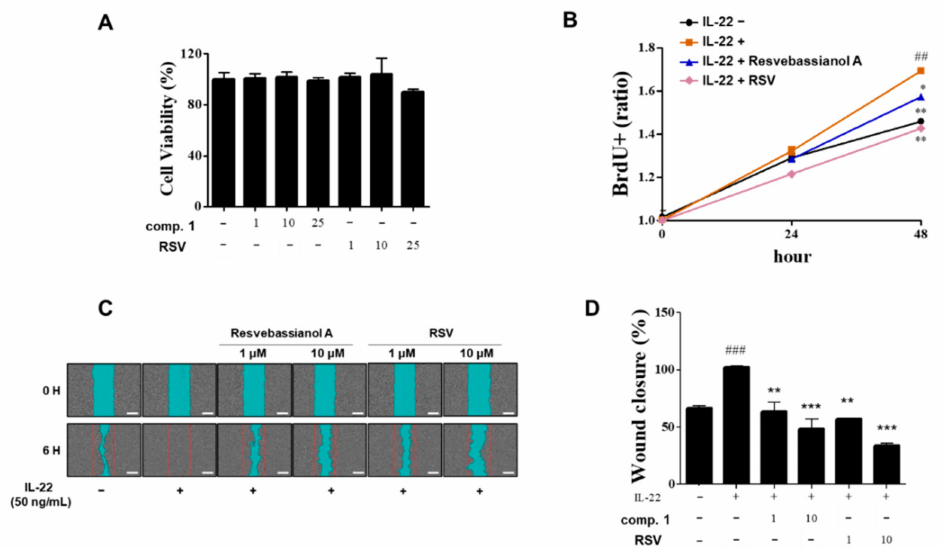
Figure 4. Effects of resvebassianol A on the proliferation and migration of HaCaT cells. ( A ) Cells were cultured in 96-well plates, and they were treated with resvebassianol A and RSV (1, 10, and 25 µ M). After 24 h cell viability was measured using the MTT assay. ( B ) HaCaT cell proliferation after 24 and 48 h of treatment with resvebassianol A and RSV was measured using BrdU incorporation assay. ( C ) The wound margin was photographed after 0 h and 6 h of wound scratching. ( D ) Quantitative analysis of wound closure was determined as the wound area at a given time relative to that of the IL-22-treated group. Values are expressed as means ± SEM. ## p < 0.01 and ### p < 0.001 versus untreated (control) group; * p < 0.05, ** p < 0.01, and *** p < 0.001 vs. IL-22-treated group.